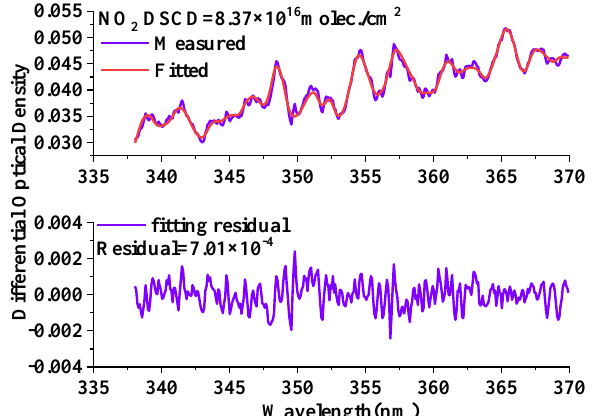
Figure 4. (Upper plot) DOAS fitting example for NO 2 ; (bottom plot) fitting residual.